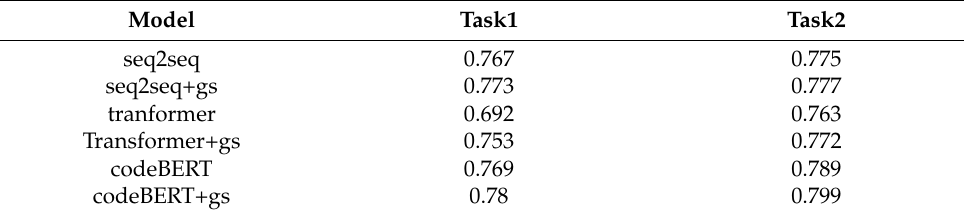
Table 6. Ablation